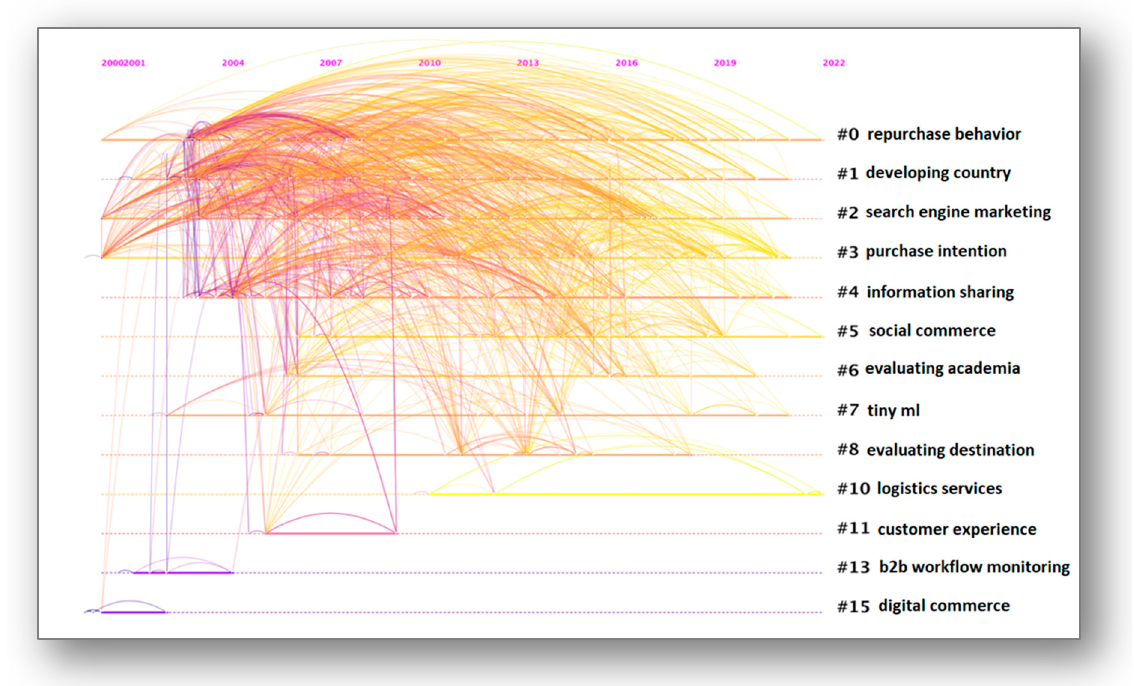
Figure 5. Timeline view for cluster labelling by title node. Table 5. Most relevant topics in electronic commerce by clusters.